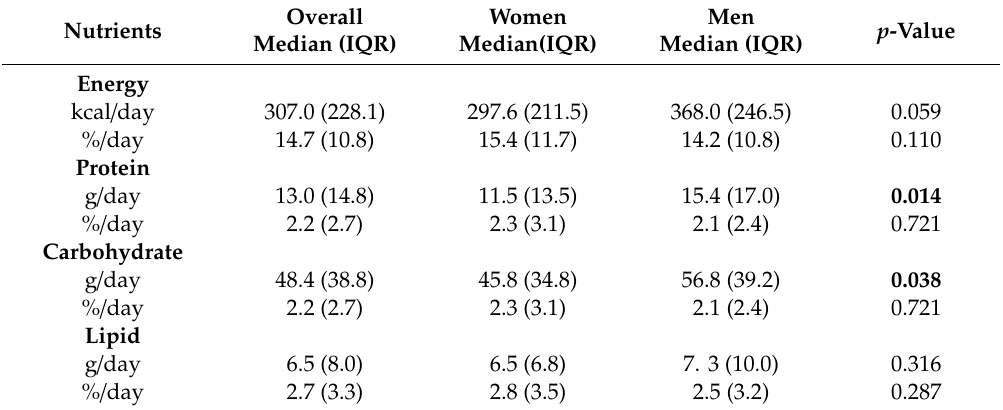
Table 2. Nutritional composition of university students’ breakfasts according to sex.